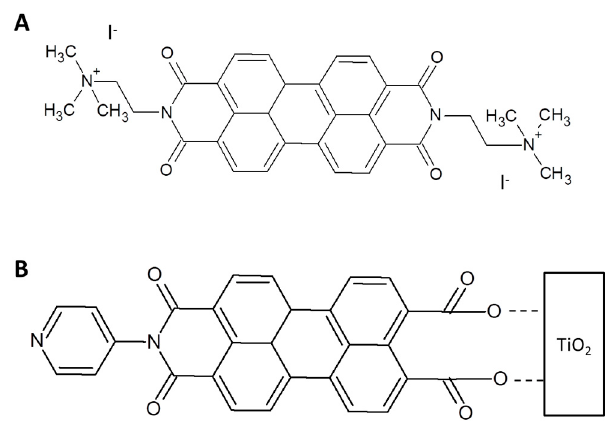
Figure 7. ( A ) Double charged PDI derivative used to form the photoactive dyad with ZnPc. ( B ) Asymmetrically substituted perylene imide linked to TiO 2 to build up a dye sensitized solar cell [76].